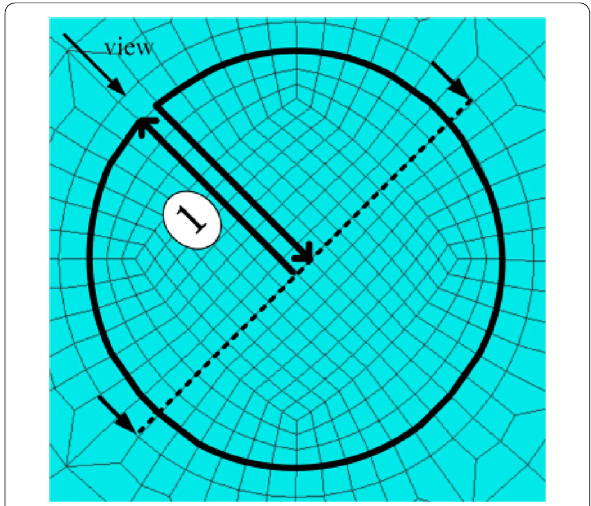
Figure 4. Such an observation direction was applied when different laser welding methods were employed.